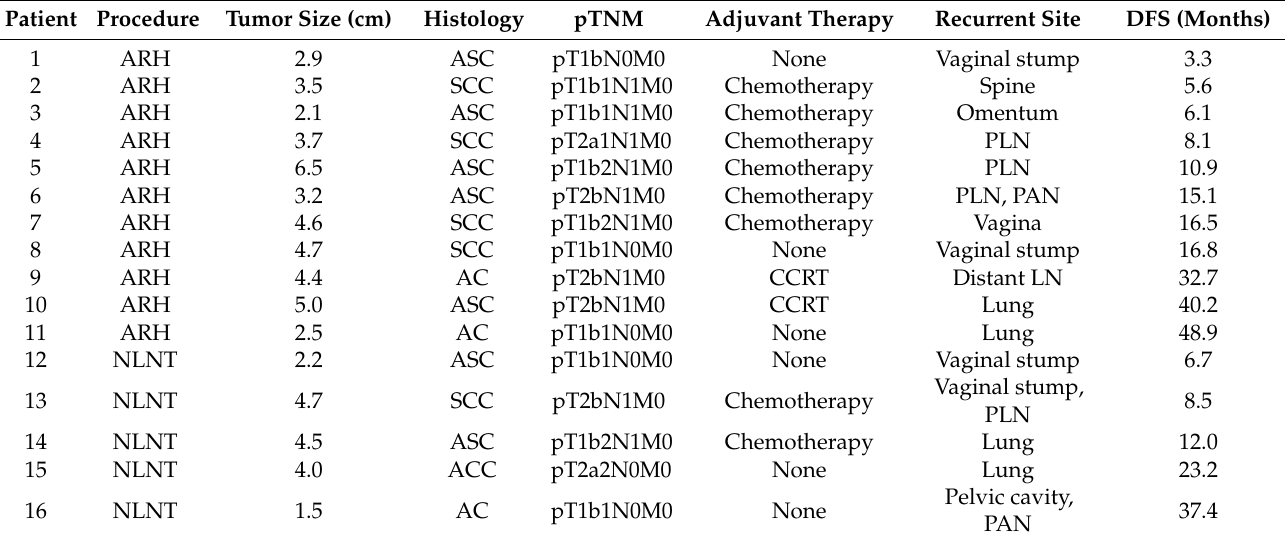
Table 3. Characteristics of patients with